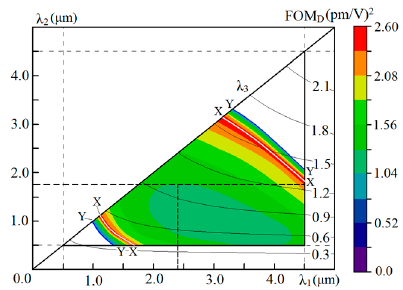
Figure 6. Distributions FOM D ( λ 1 , λ 2 ) for KTP crystal with FNCPM for pulse with λ 1 .